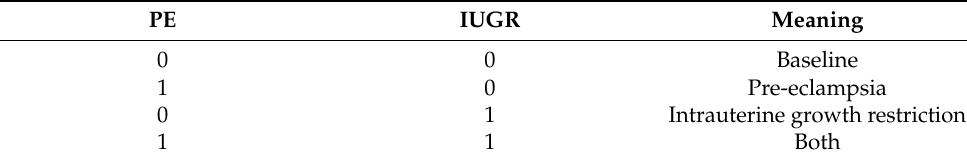
Table 2. Possible output of the multi-label classification model.